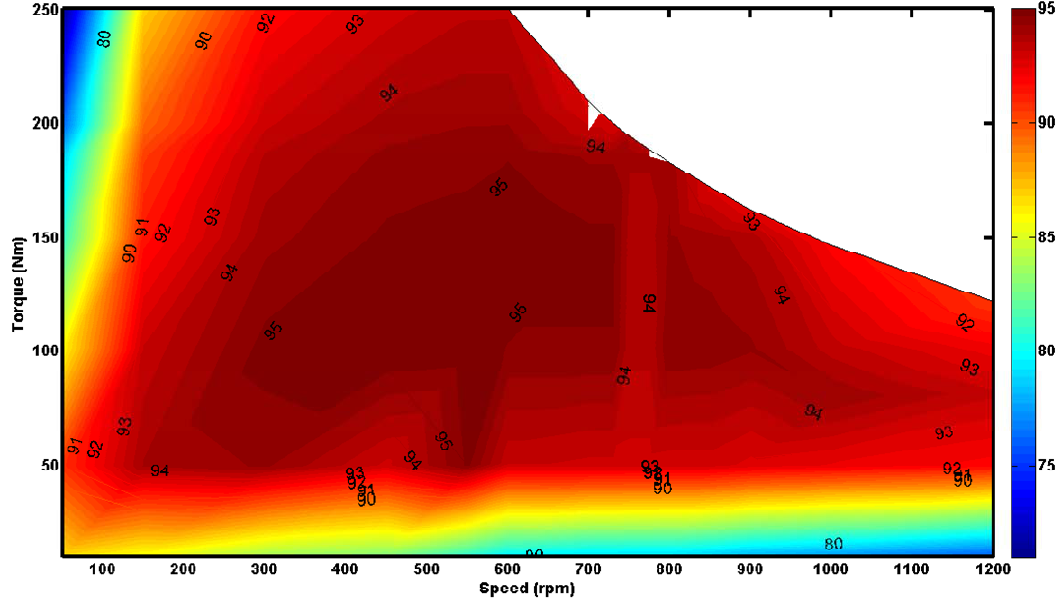
Figure 17. Efficiency map in all speed